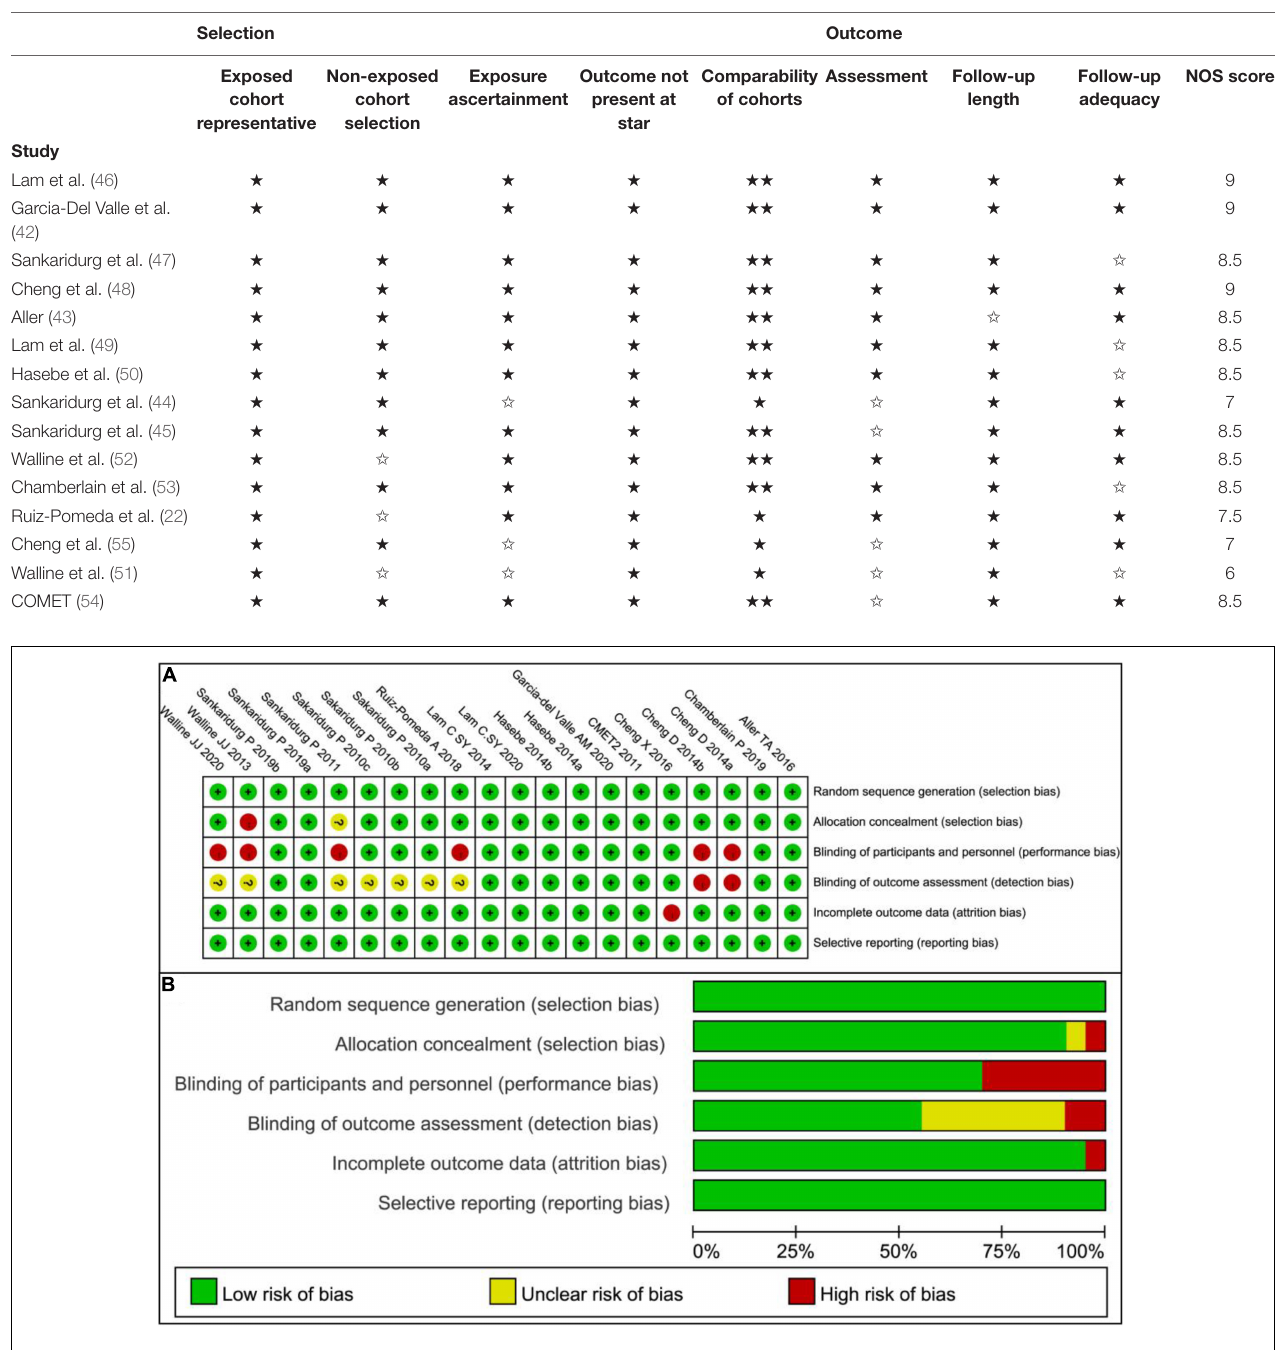
FIGURE 2 | Risk of bias graph. (A) Risk of bias summary: Review authors’ judgments about each risk of bias item for each included study. (B) Risk of bias graph: Review authors’ judgments about each risk of bias item presented as percentages across all included studies.